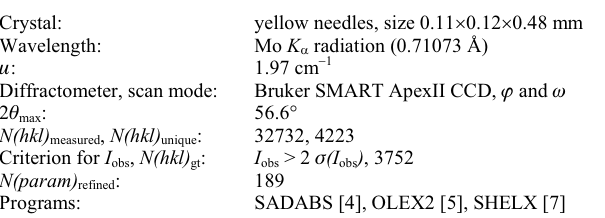
Table 1. Data collection and handling.